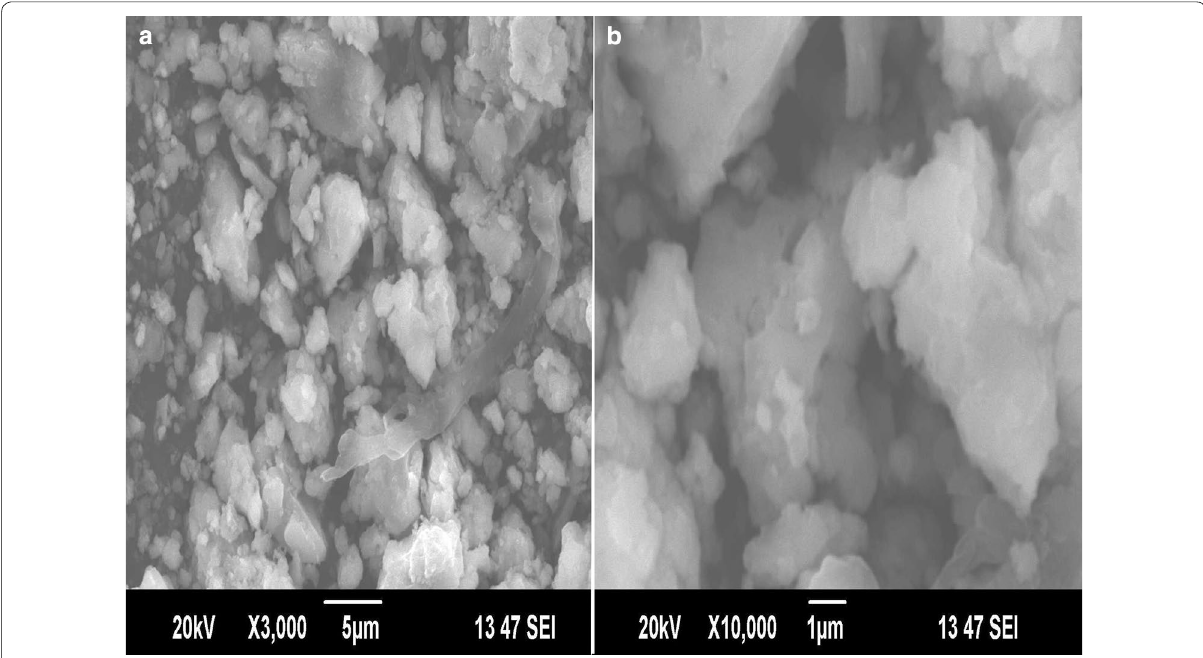
Fig. 5 SEM micrograph of AFNP. a The magnification scale of 5 μm shows the orthorhombic crystals, b the magnification scale of 1μm shows the size of the crystals that are in nanometric